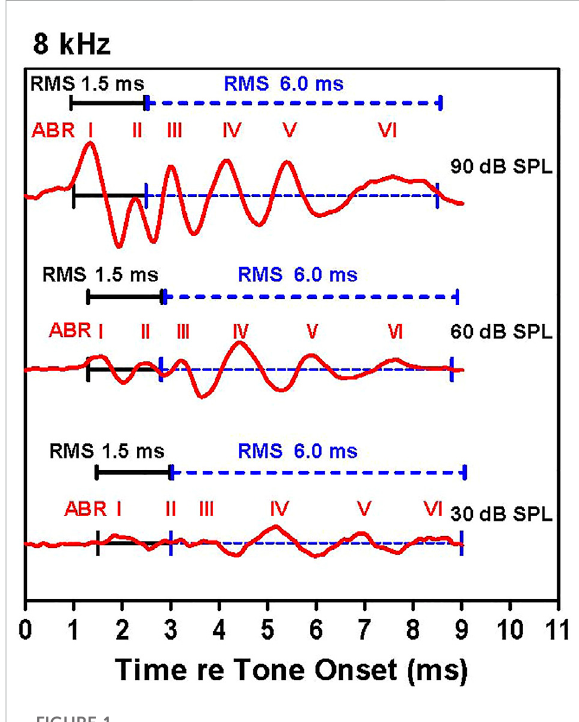
FIGURE 1 Examples of auditory brainstem response (ABR) waveforms elicited by8 kHz tone bursts. Theearly(1.5 msduration,black line) andlate(6.0 msduration, dashedblueline)RMSanalyses windows are shown along with the major ABR peaks labeled I through VI. The early analysis window starts at the onset of wave I and continues for 1.5 ms; this is immediately followed by the 6.0 ms late analysis window. The latency of the ABR peaks increased as intensity decreased causing a slight rightward shift of the analysis windows as intensity